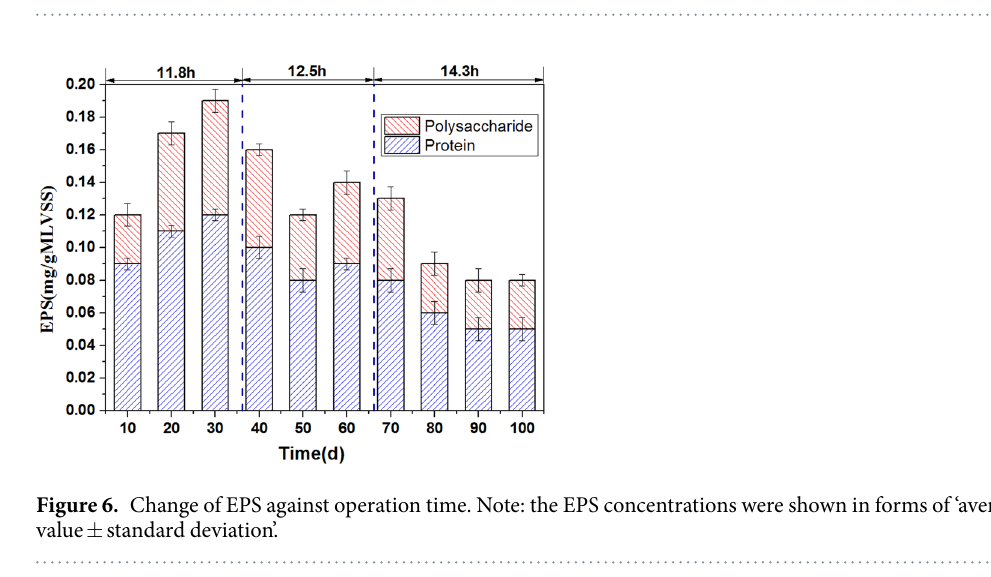
Figure 5. FT–IR spectra of the membrane foulants, SMP and EPS.